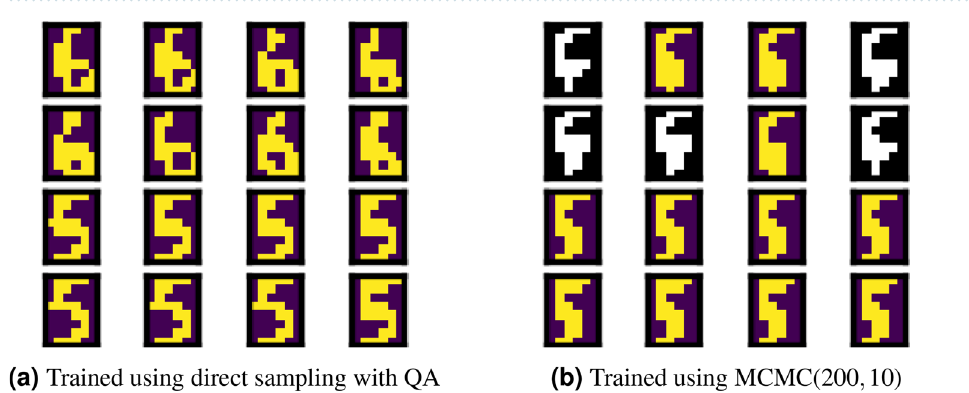
Figure 7. Images generated using QA with low energy at epoch